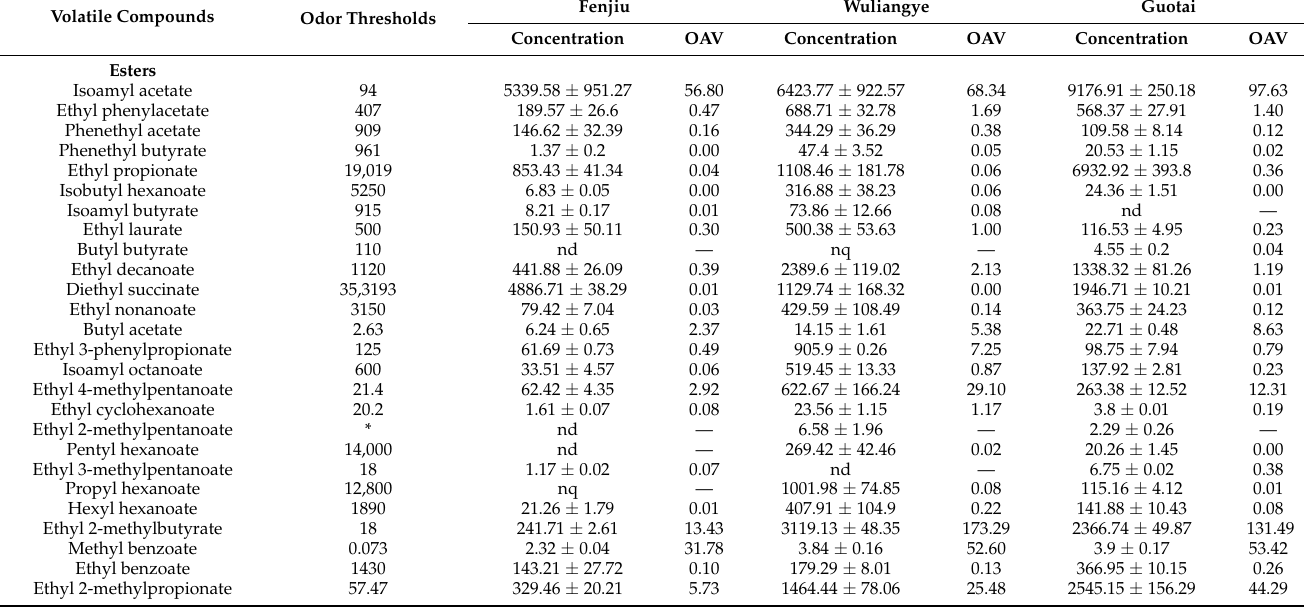
Table 3. Concentrations ( µ g/L) of volatile compounds in three different types of